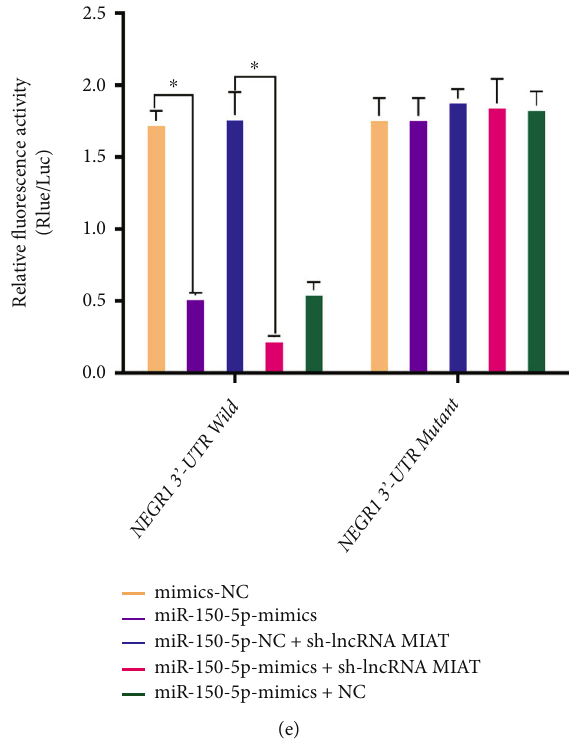
Figure 5: MIAT competitively inhibits the binding of miR-150-5p to NEGR1. (a) Relative expression of MIAT based on qRT-PCR. (b) Relative expression of miR-150-5p based on qRT-PCR. (c) Relative expression of NEGR1 based on qRT-PCR. (d) Interaction between MIAT and miR-150-5p based on the luciferase reporter gene. (e) Interaction between miR-150-5p and NEGR1 based on the luciferase reporter